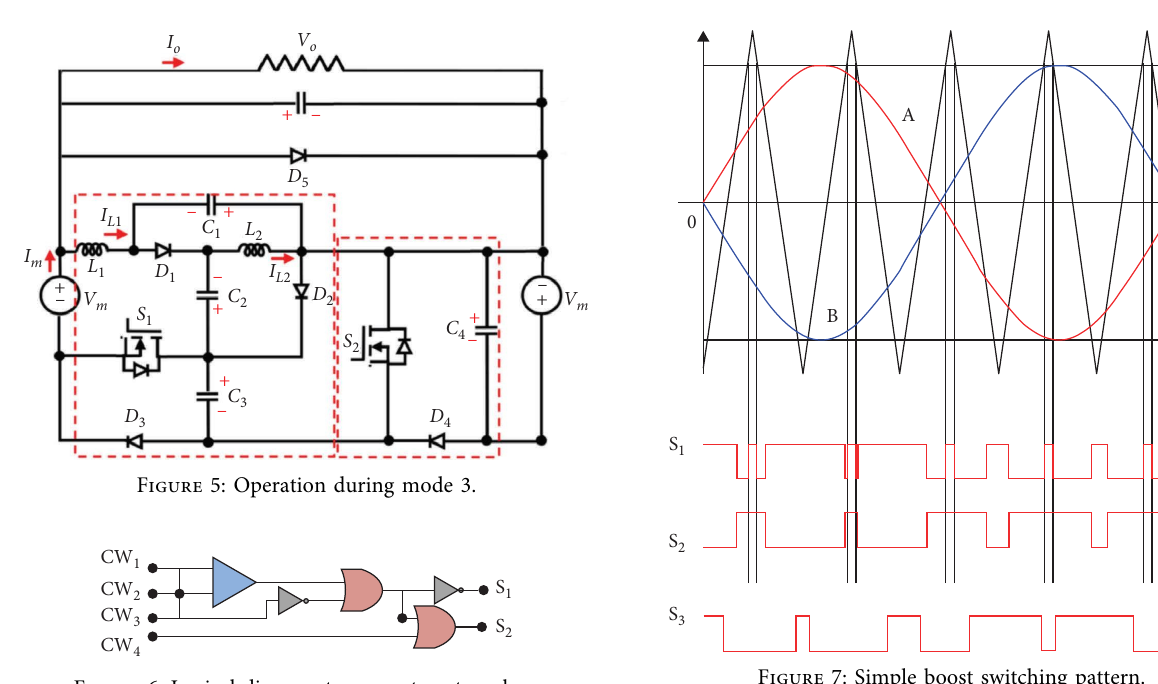
Figure 7: Simple boost switching pattern.